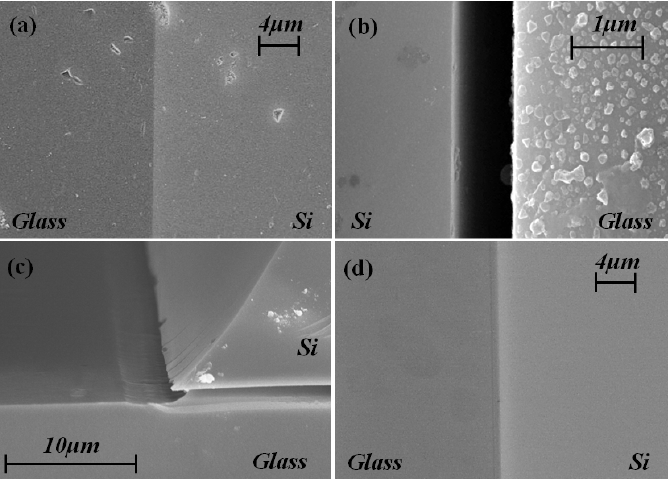
Figure 1. Cross-section of Silicon/Glass joint under 1000 V with 380 °C bonding: ( a ) non-etching bonding joint; ( b ) bonding joint etched for 10 min; ( c ) edge of joint after 1 min etching; ( d ) bonding wafer under 560 °C and 6 h post annealed then etching for 10 min.